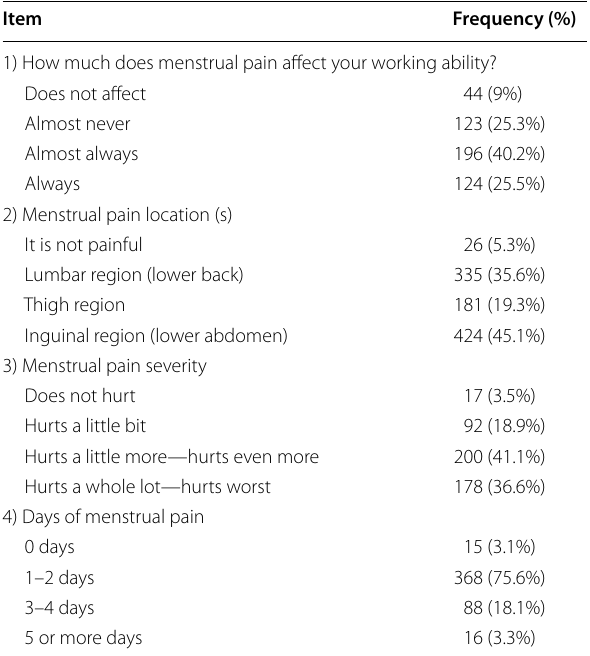
Table 2 Descriptive analysis of the dysmenorrhea WaLIDD score